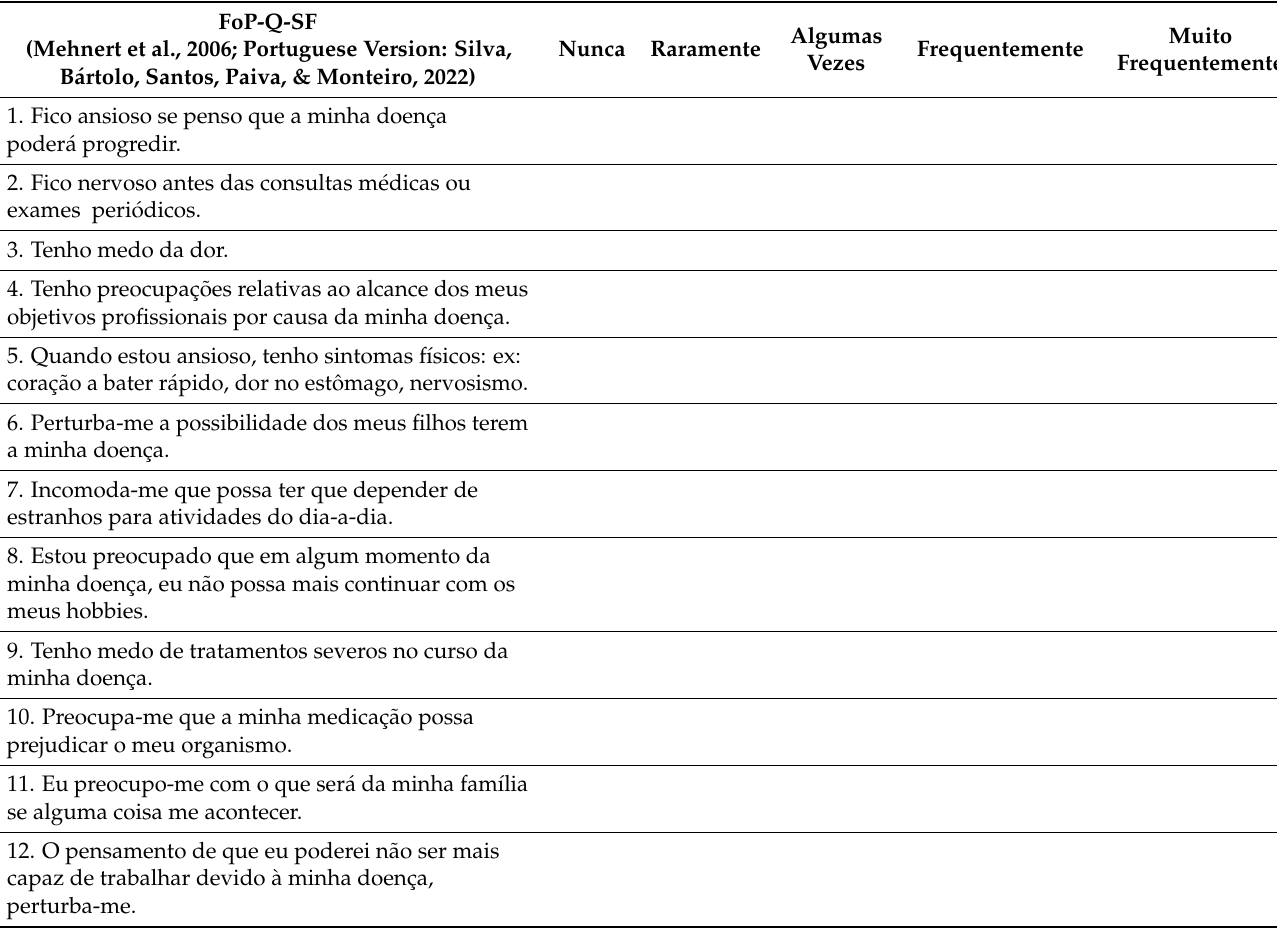
Table A1. Fear of Progression Questionnaire-Short Form (FoP-Q-SF)-Portuguese